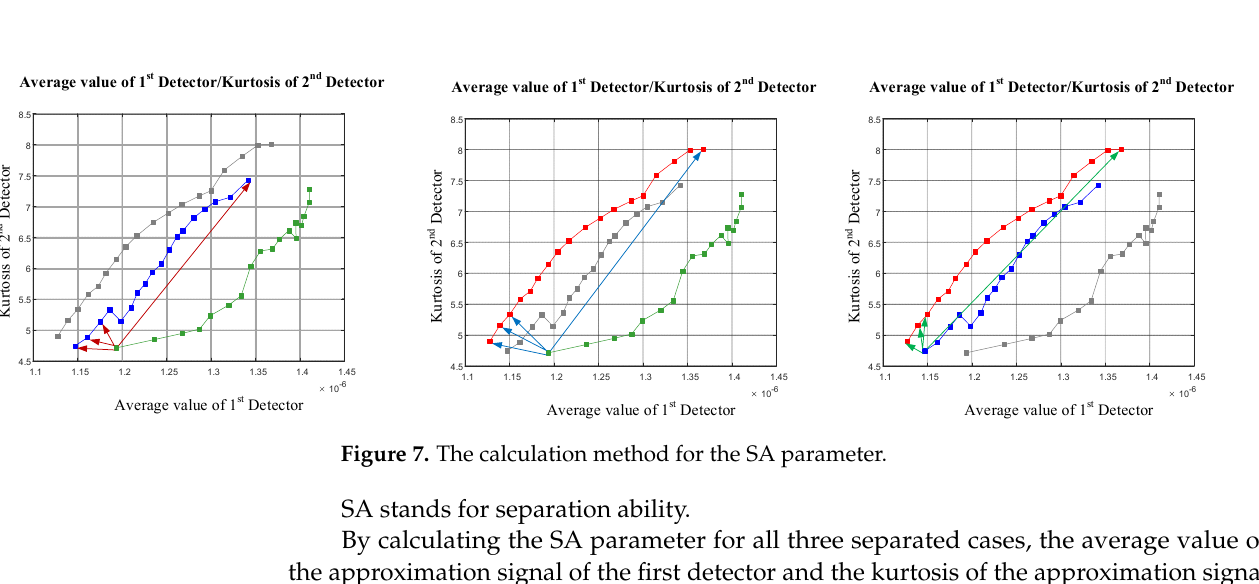
Figure 6. One of the features with separated graphs.